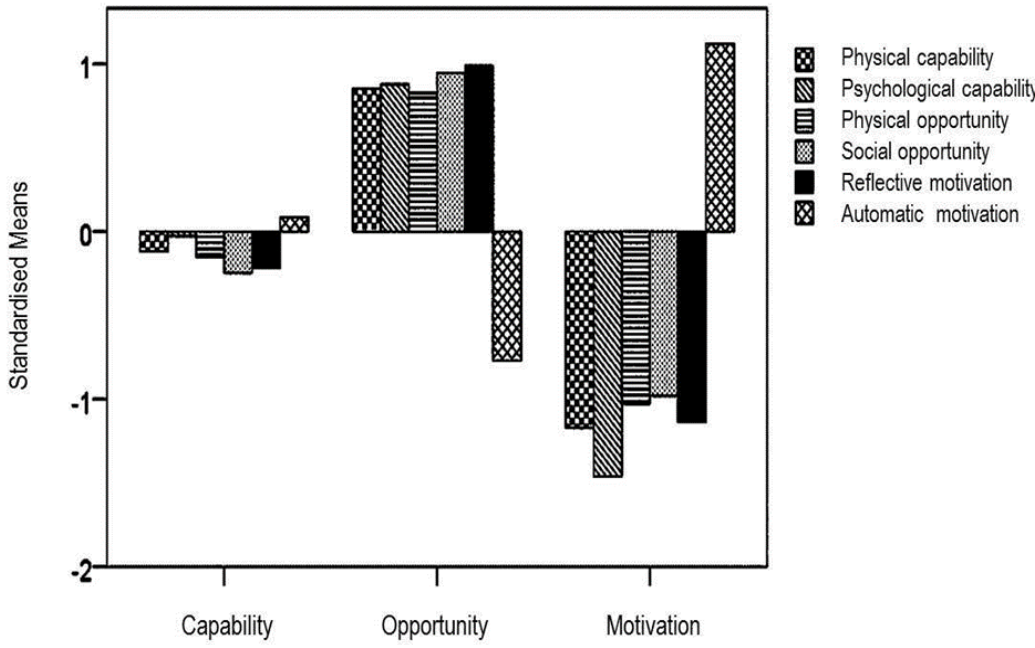
Figure 2. Profile characteristics explaining the 3 profile groups by their attitudes, barriers and drivers of water-conservation behavior ( N = 510). Sample average = 0.